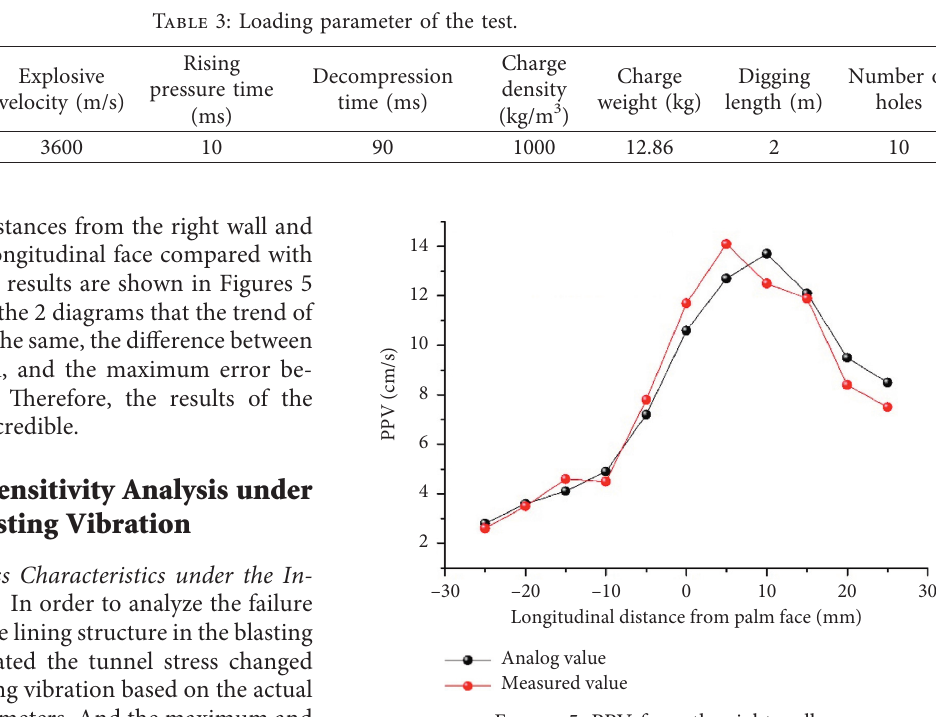
Figure 5: PPV from the right wall.